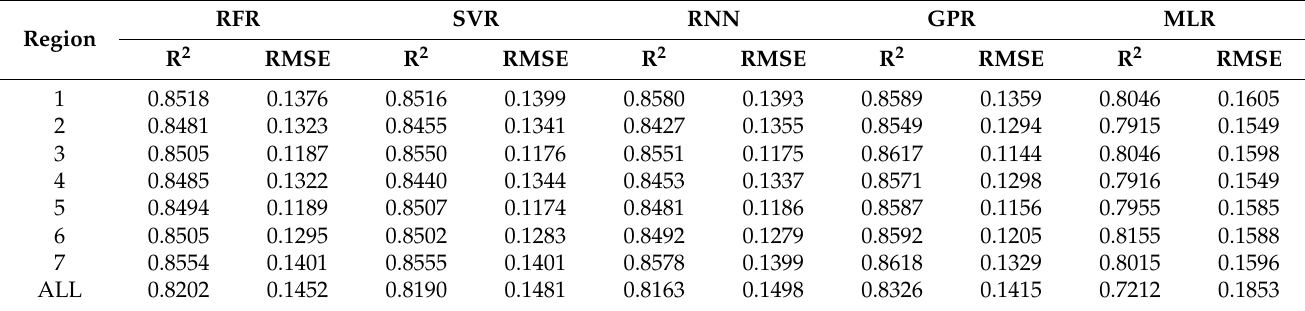
Table 4. Prediction results of different models based on regional